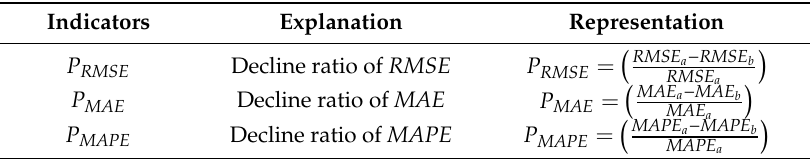
Table 4. Decline ratios of metrics RMSE, MAE, and